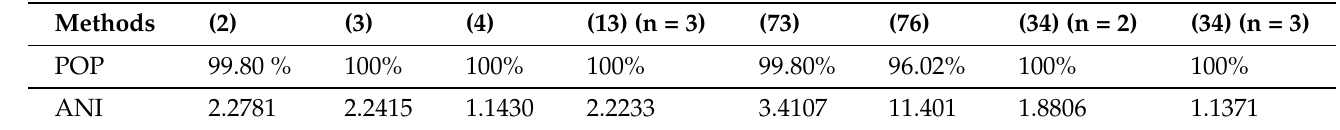
Table 1. Numerical results of different methods for z 2 − 1 = 0.